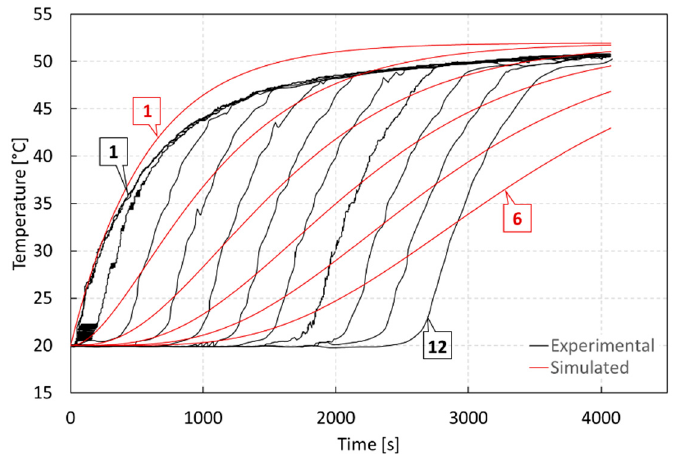
Figure 6. Temperature evolution during the charge phase—experimental vs. simulated (6 nodes).